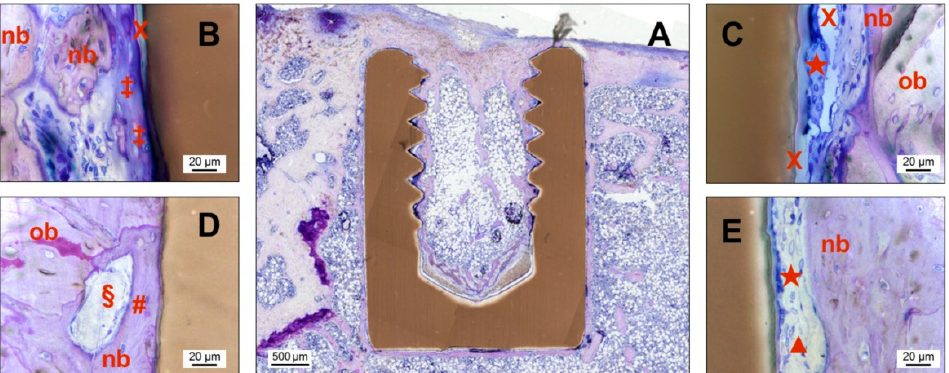
Figure 6. Images of undecalcified cut and ground sections of the PI and SPI group after different time points postoperatively. The sections were histologically stained with a mixture of Giemsa and toluidine blue. ( A ) Overview image of an uncoated pure PEEK implant (PI) after 8 weeks showing new bone formation around the implant outline. ( B – E ) Additional detail images with higher magnification focusing on the direct bone-implant contact area for SPI (2 weeks ( B ) and 8 weeks ( D )) and PI (2 weeks ( C ) and 8 weeks ( E )). Note: nb—new bone, ob—old bone, X—preparation artifact, (cid:70) —elongated irregular-shaped giant cell, ‡—osteoid, #—osteocyte in contact to the implant surface, §—blood vessel, (cid:78)